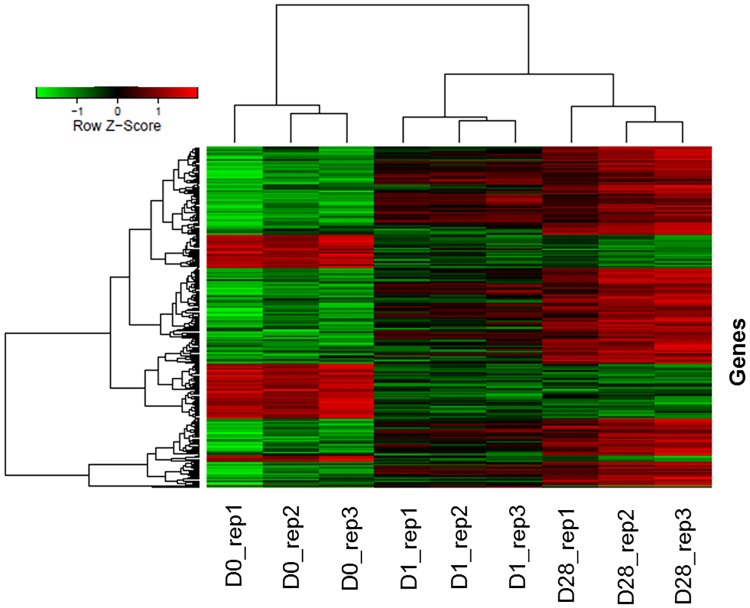
Hierarchical heat map showing the expression dynamics of DEGs.Normalized log2 transformed values as determined by Affymetrix GeneChip® porcine gene 1.0 ST array in PBMCs of Pietrain pigs collected at D0, D1 and D28 of PRRSV vaccination. Each column represents one pig, three replicates at each time point, each horizontal line refers to one gene. The cutoff value of log fold change as >1.5 or <−1.5 and false discovery rate <0.01 was considered.